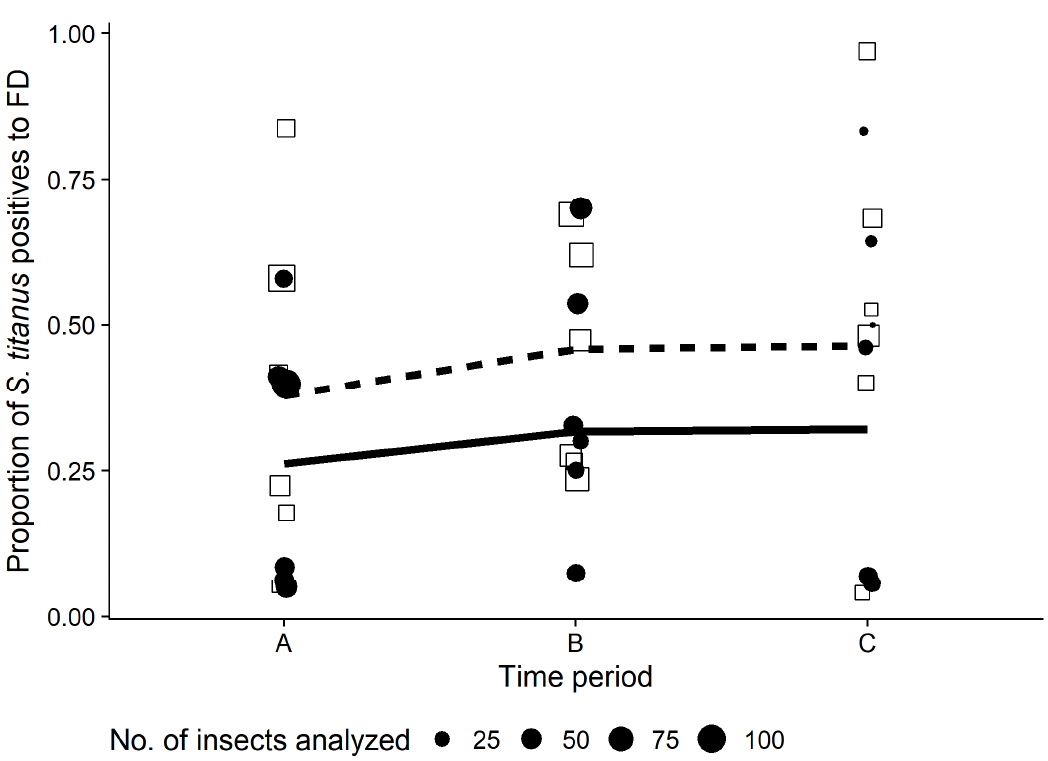
Figure 6. Proportion of FDp-positive S. titanus throughout the season in Piedmont vineyards. Black points and continuous line represent data and GLMM model of traps located inside the vineyard, whereas white squares and dashed line represent data and model of traps located outside the vineyard. Size of points and squares is proportional to number of insects analyzed for each trap.